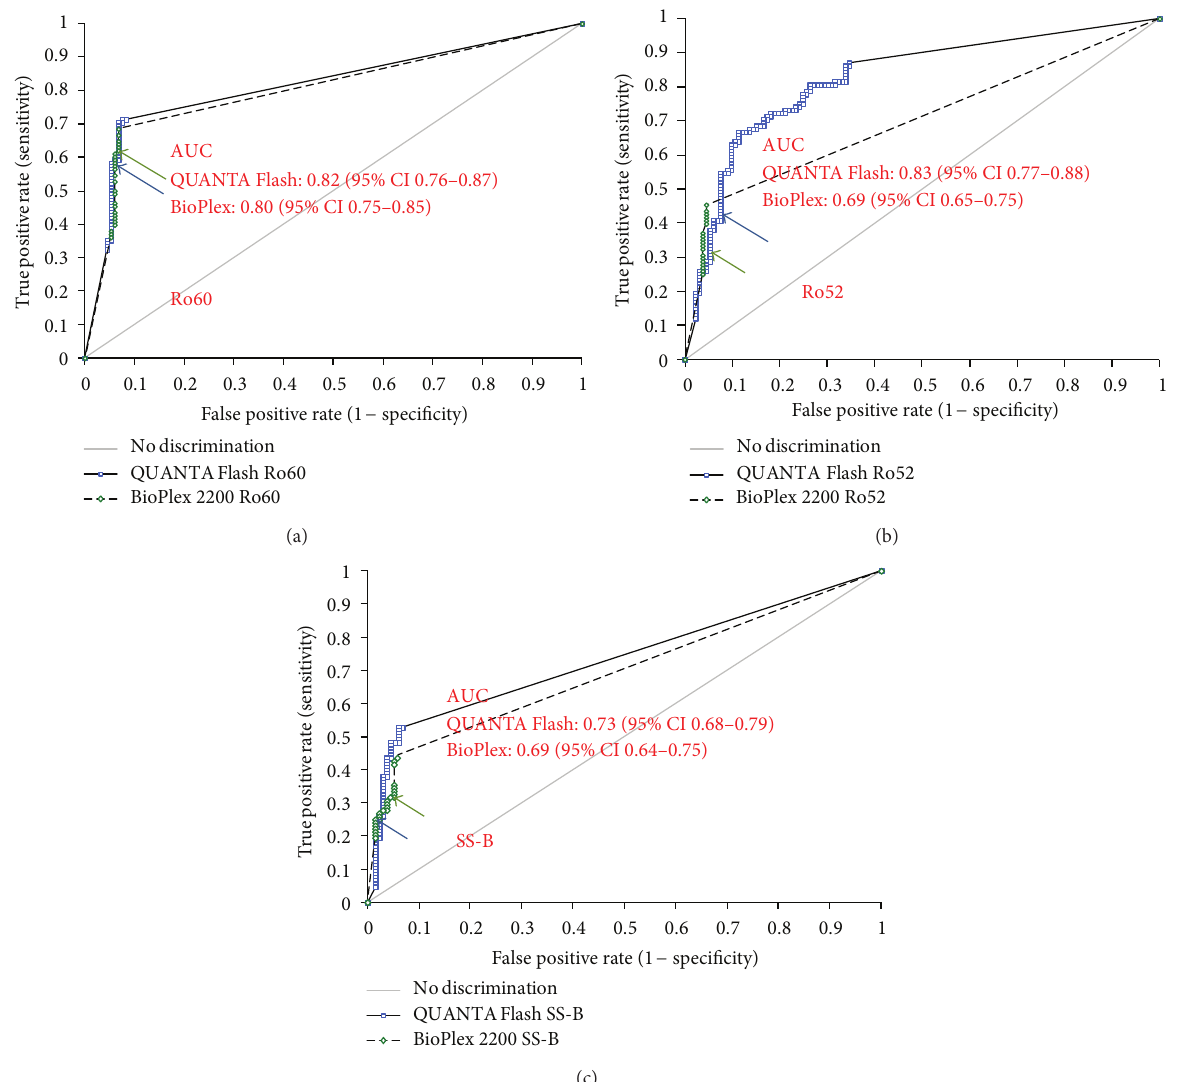
Figure 3: Clinical comparative ROC analysis. Results of patients with systemic autoimmune rheumatic diseases were compared with controls. Cut-off values are indicated by arrows. For sensitivity and specificity, see Table 1. Results for anti-Ro60 (a), anti-Ro52 (b), and anti-SS-B antibodies (c) are shown.